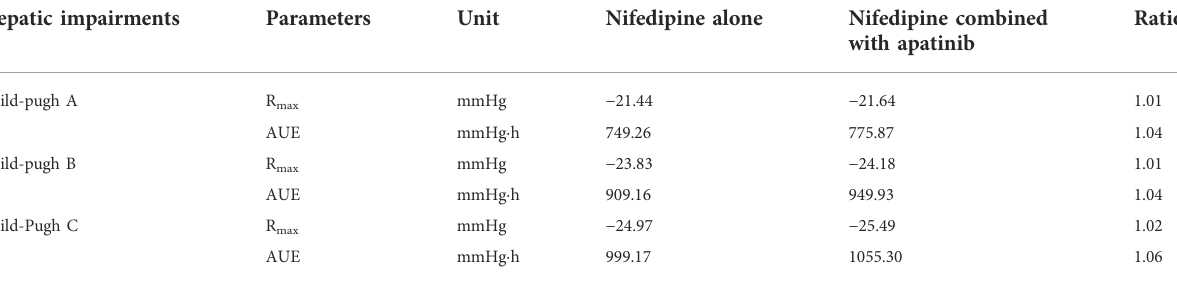
TABLE 7 Calculated R max and AUE ratio in the presence to the absence of apatinib in patients with hepatic impairments at a single dose of 60 mg nifedipine CR tablet. Hepatic